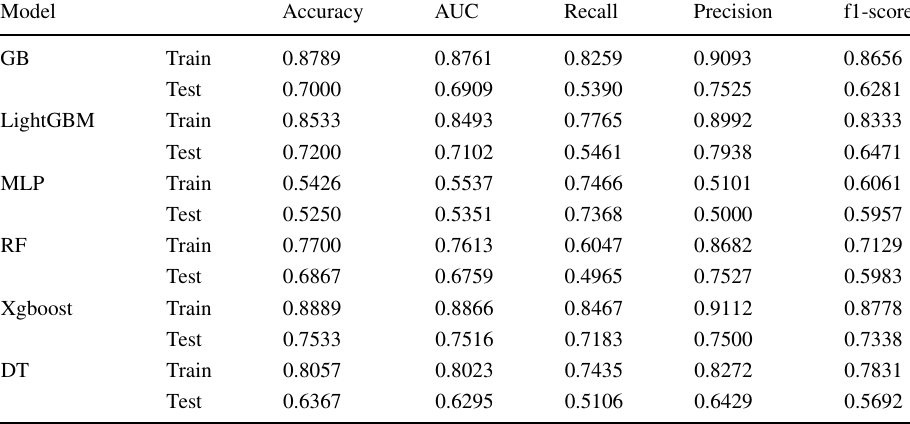
Table 2 Comparison results of individual machine learning algorithms